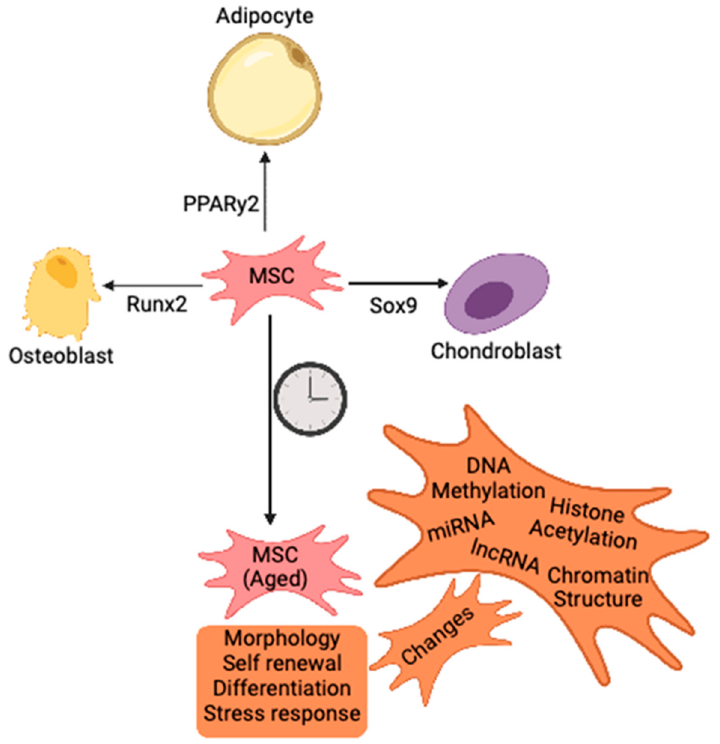
Figure 1. Molecular regulation of MSC cell fate. MSC differentiation is driven by a number of master regulators into the various lineages, including osteoblasts (Runx2), adipocytes (PPARy2) and chondroblasts (Sox9). Aged MSC show changes in phenotypes and differentiation properties, an e ff ect of the changing epigenetic landscape within the cell.